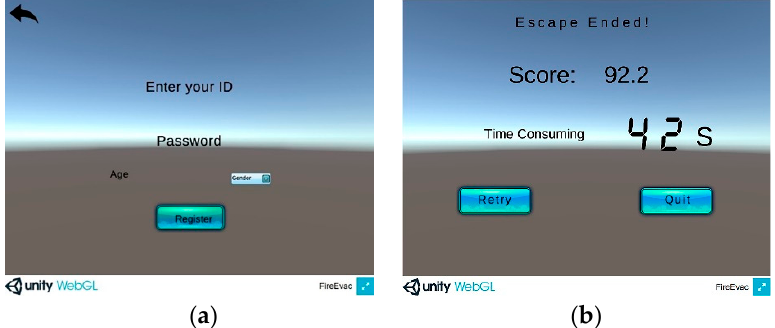
Figure 8. The developed serious game. ( a ) User registration; ( b ) Evacuation results.